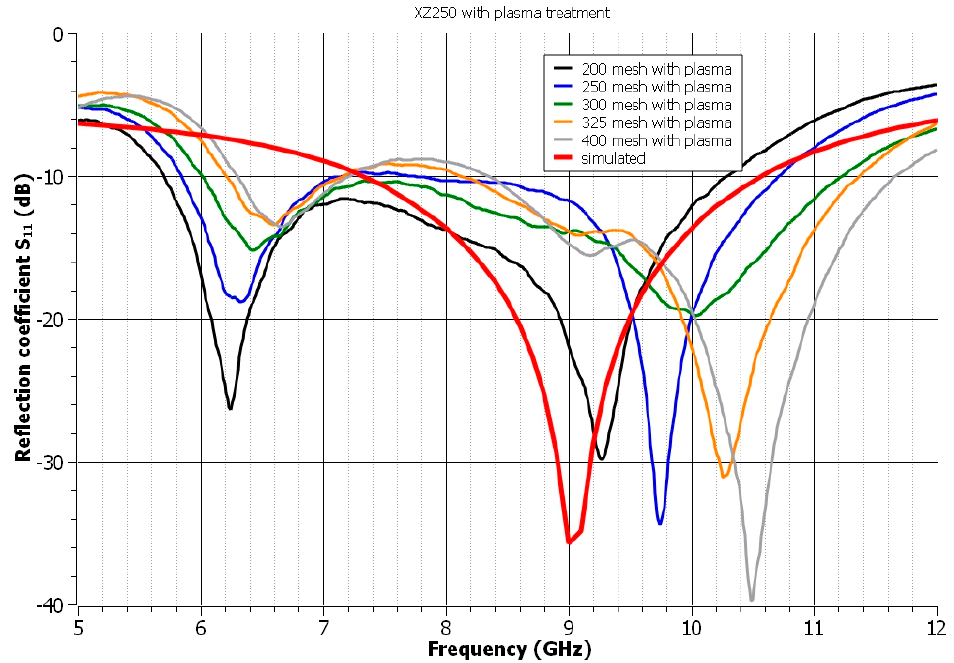
Figure 3. The influence of the mesh of the used screens on the reflection coefficient of the antenna after the plasma treatment—paste XZ250.